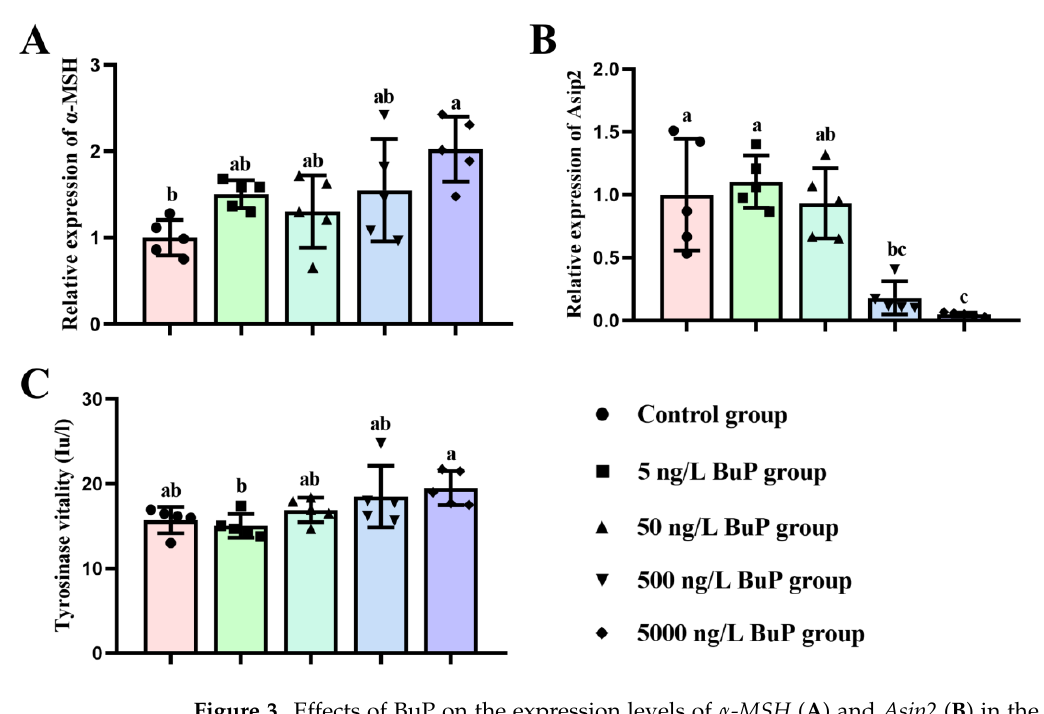
Figure 3. Effects of BuP on the expression levels of α -MSH ( A ) and Asip2 ( B ) in the brain tissues, and the activity of Tyr ( C ) in the skin tissues. Means of groups not sharing a common letter are significantly different at p < 0.05.